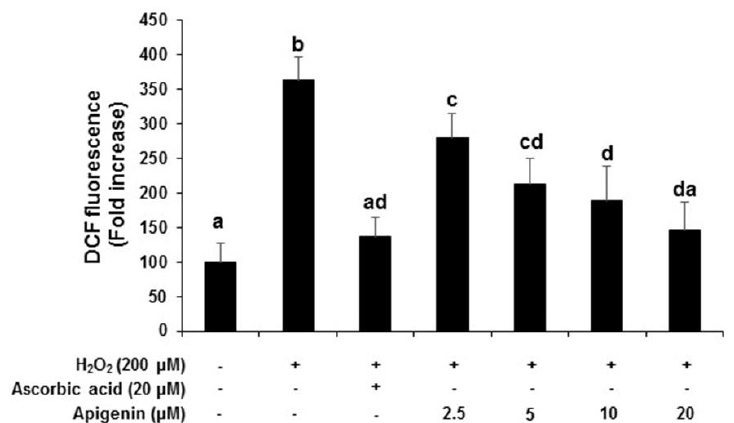
Figure 3. Effect of apigenin on the inhibition of intracellular ROS formation. DCFH-DA fluorescence assay was performed and the fluorescence intensity (fold increase) in each treated group compared with control was shown. H 2 O 2 (200 µ M) treatment significantly increased the fluorescent intensity (fold increase) compared to control cells. Apigenin (2.5, 5, 10 and 20 µ M) and positive control ascorbic acid (20 μM) treatment inhibited the H 2 O 2 -exposed increase in ROS generation by decreasing the florescence intensity in GC-2spd cells. Data are expressed as the mean ± standard deviation. The groups of control, H 2 O 2 , ascorbic acid, and different concentrations of apigenin were compared with each other and letters on the top of the columns that do not share the same letters are statistically significant among the groups ( p < 0.05) by one-way ANOVA.